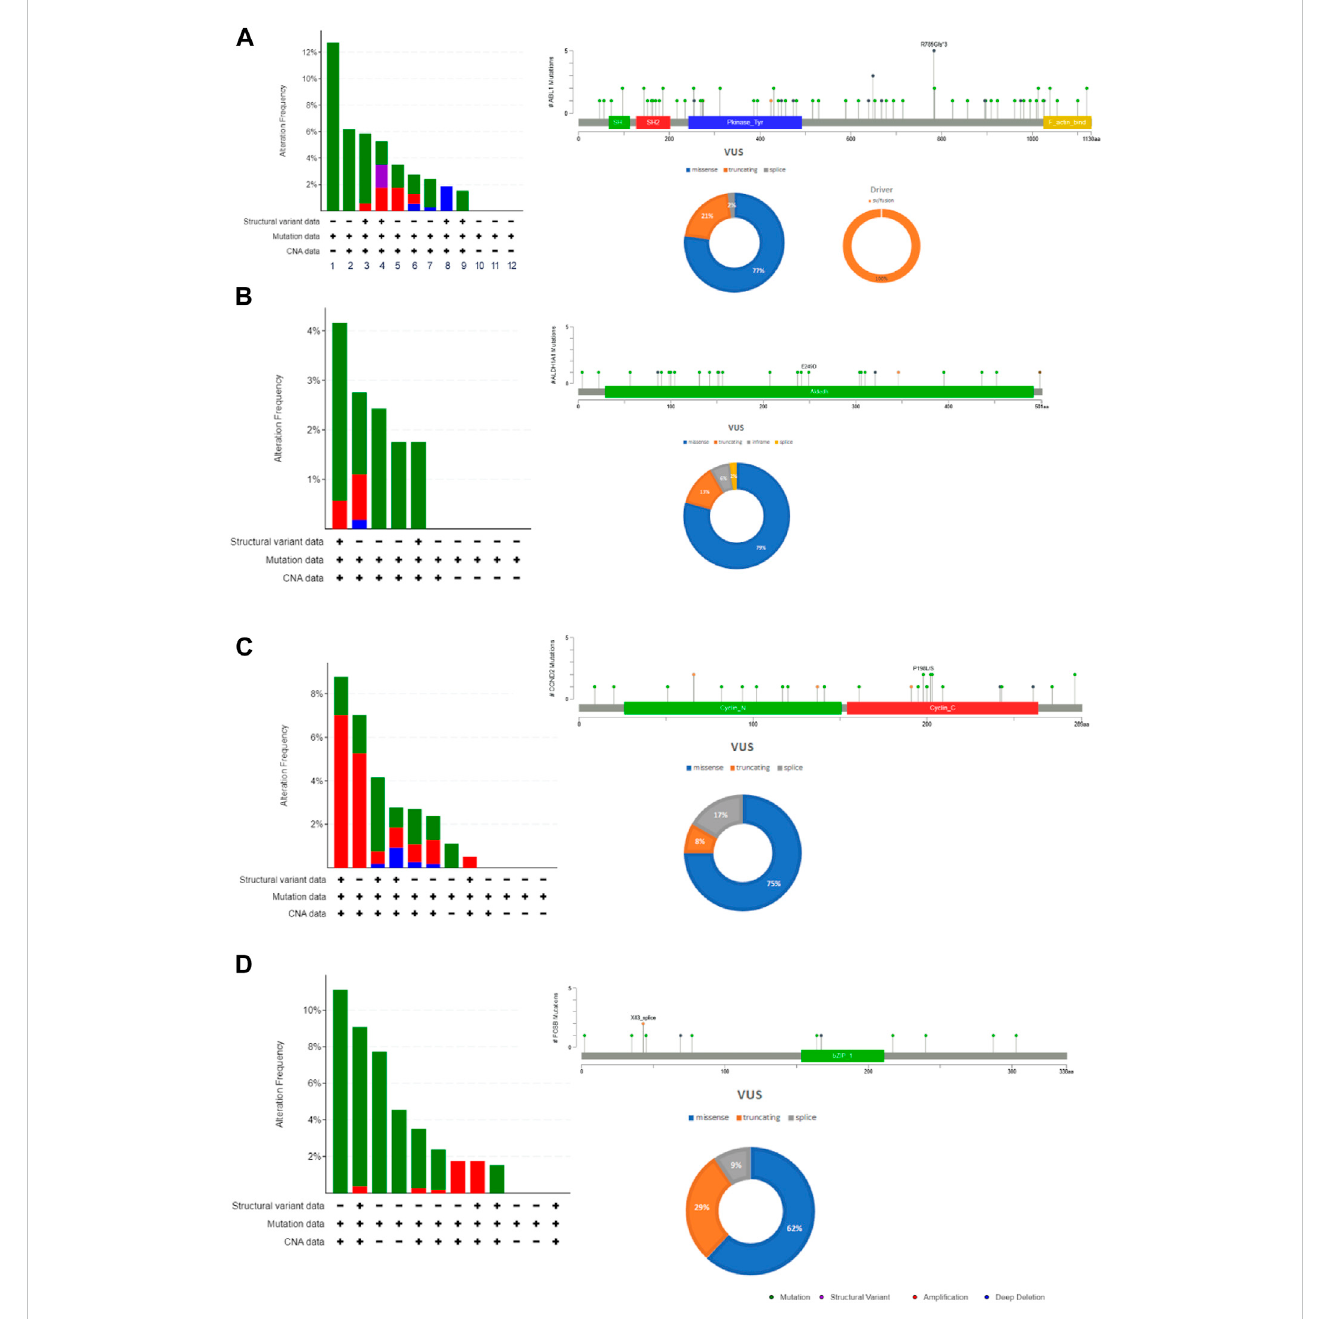
FIGURE 3 The mutation load of hub genes in endometrial cancers. (A) . ABL1 , (B) . ALDH1A1 , (C) . CCND2 (D) . FOSB . The distribution and frequency of genetic changes in endometrial cancer ’ s hub genes. The lollipop plot and pie chart determine the type of mutation and localization of the mutation in a protein.